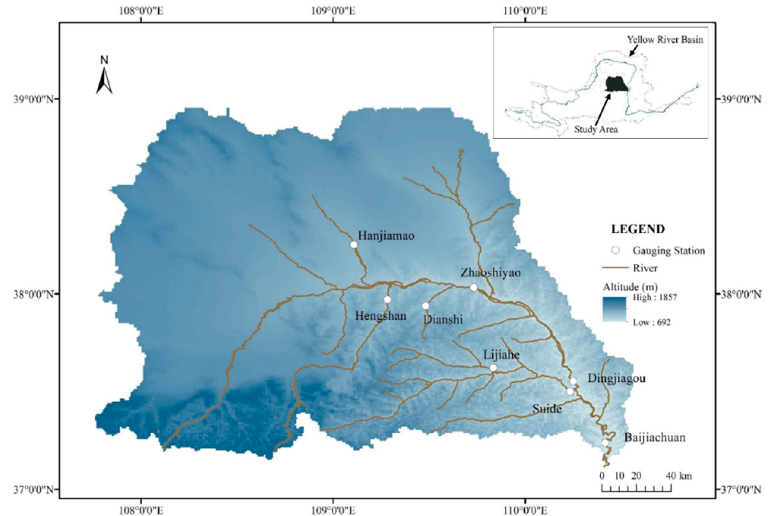
Figure 1. Tributaries and gauging stations in the Wuding River basin.